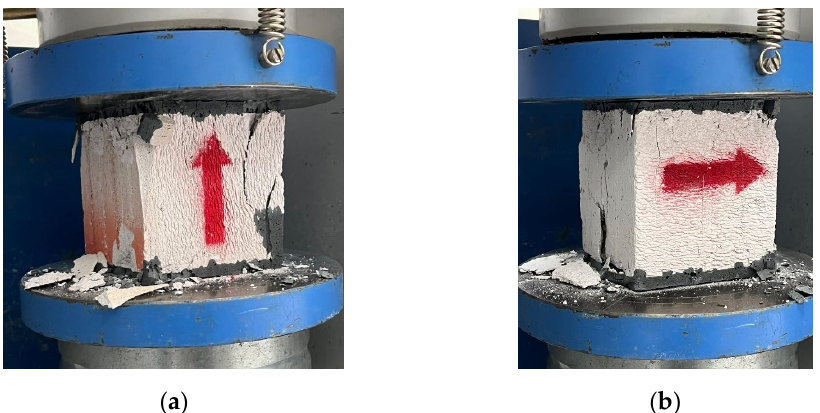
Figure 3. Compressive strength testing of AAC cubes ( a ) parallel to the rise and ( b ) perpendicular to the rise.